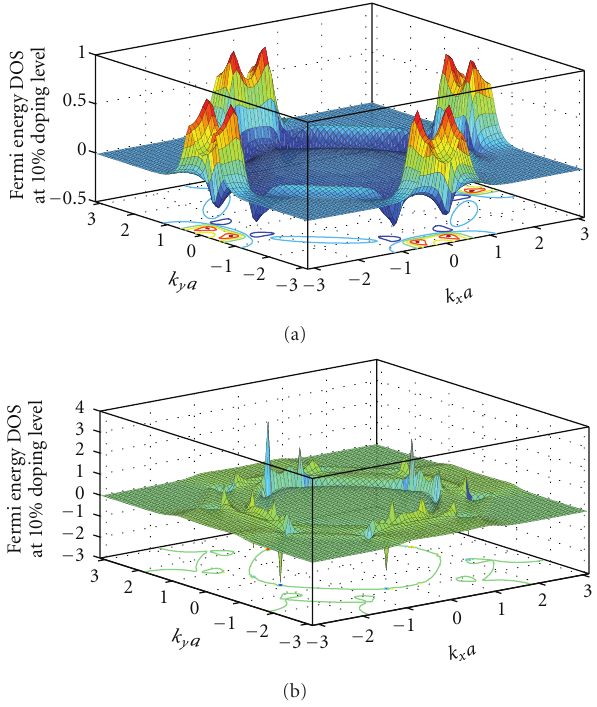
Figure 3: The 3D plots of the Fermi energy DOS on the Brillouin zone (BZ) at 10% hole doping and B = 45Tesla. (a) The anisotropy parameter ´ ε = 0 and the level broadening factor γ = 0 . 0357eV. (b) ´ ε = 0 and γ = 0 . 2436eV. The features for B = 45T are by and large the same as in Figure 2.